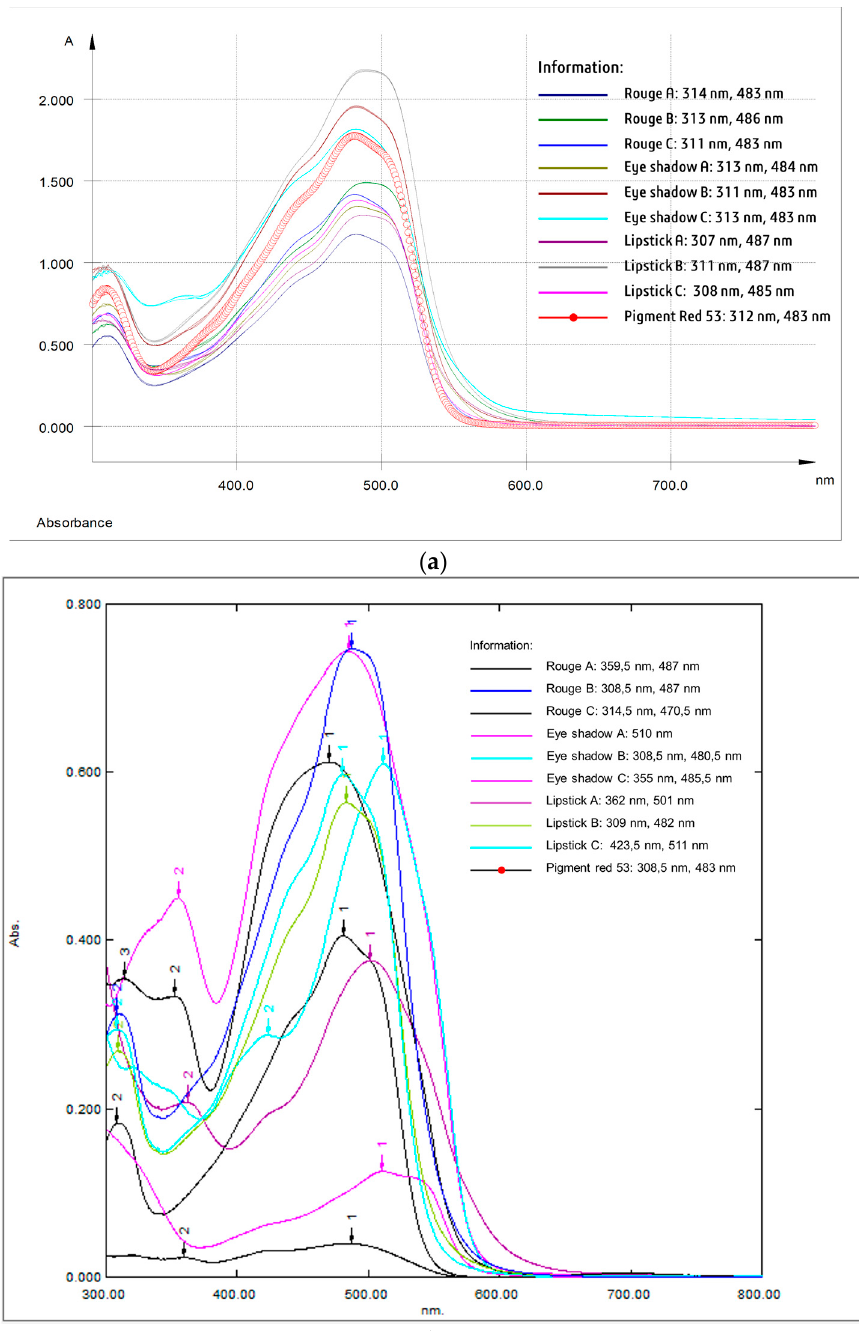
Figure 1. ( a ) UV-visible spectrum profile of spiked samples, ( b ) UV-visible spectrum profile of pure samples.